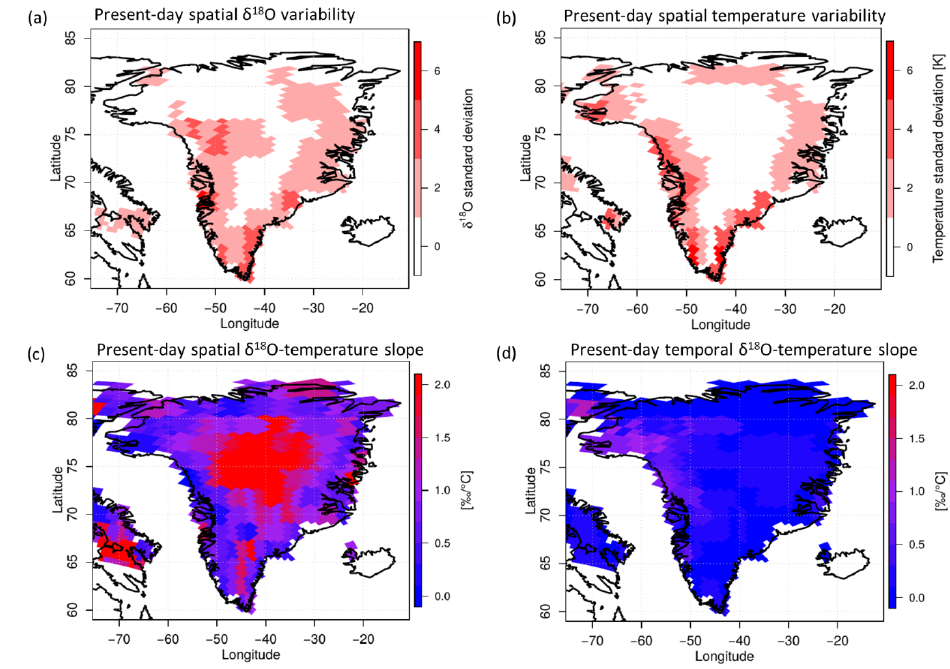
Figure 7. Present-day spatial subgrid-scale variability (calculated as standard deviation) of (a) δ 18 O and (b) surface temperature, derived from the COSMO_iso_50km grid boxes within the respective ECHAM5-wiso grid boxes for all of Greenland. Present-day (c) spatial and (d) interannual temporal δ 18 O–temperature slope for Greenland, based on yearly mean